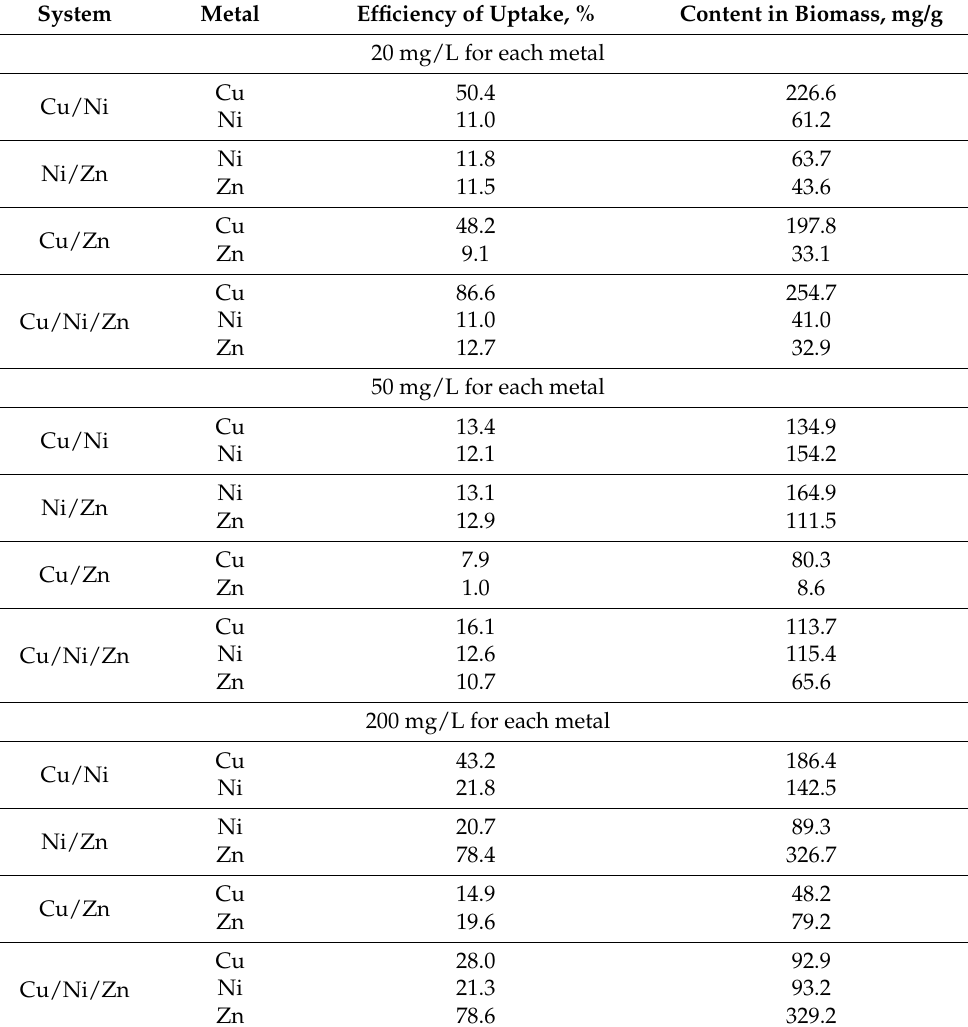
Table 2. The content of metal accumulated in biomass and the efficiency of metal uptake from multi-metal